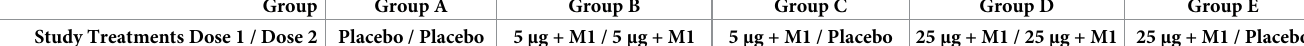
Table 3. Microneutralization immune responses (MN 50 ) for NVX-CoV2373 study treatments by study group and age subgroup (18 to 59 years and 60 to 84 years). Group Group